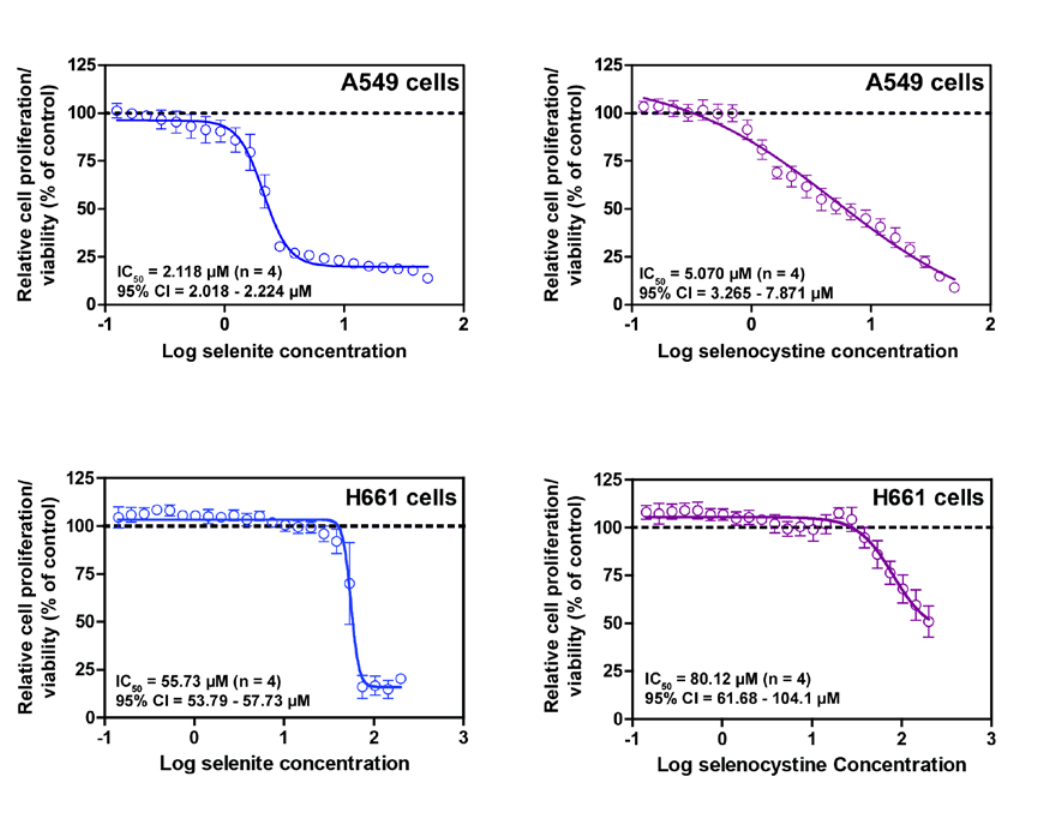
Figure 7. Cytotoxicity of selenite and selenocystine, as measured by a WST-1 assay kit (Roche, Mannheim, Germany), to A549 and H661 cells following 24 h exposure to 22 different selenium concentrations. The highest concentration of selenite and selenocystine was 50 and 200 µM for A549 and H661 cells, respectively. Note that due to low toxicity of selenocystine in H661 cells, the IC 50 value should be interpreted